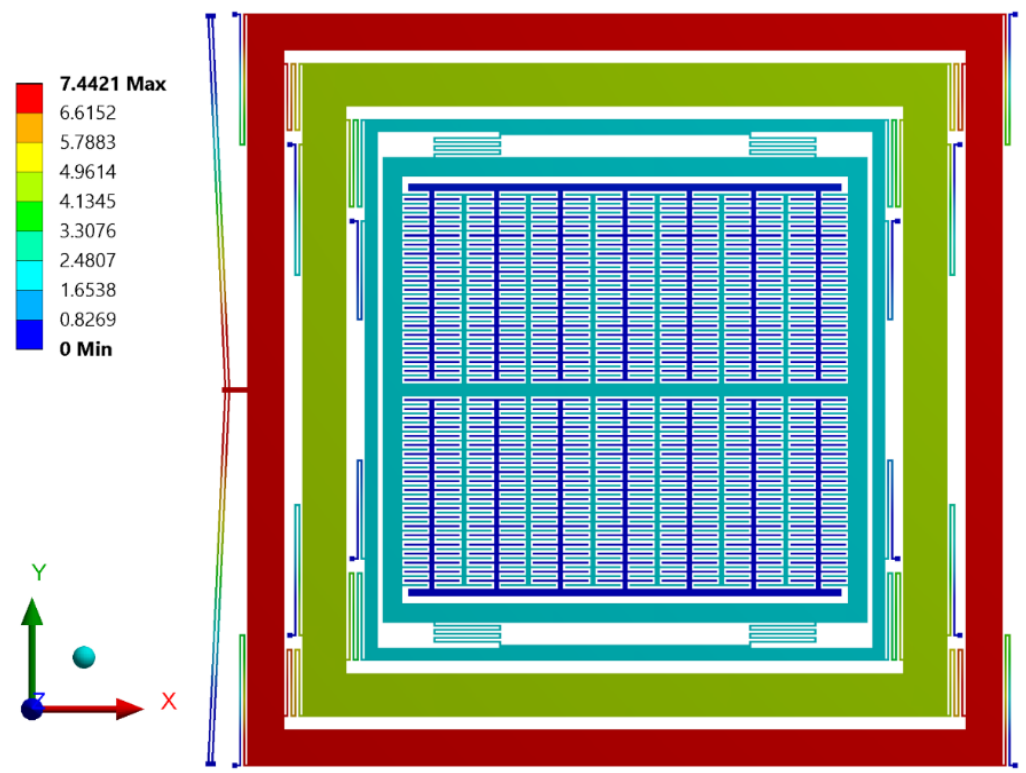
Figure 18. Thermo-mechanical analysis showing the maximum displacement achieved by the device at 0.2 V DC.